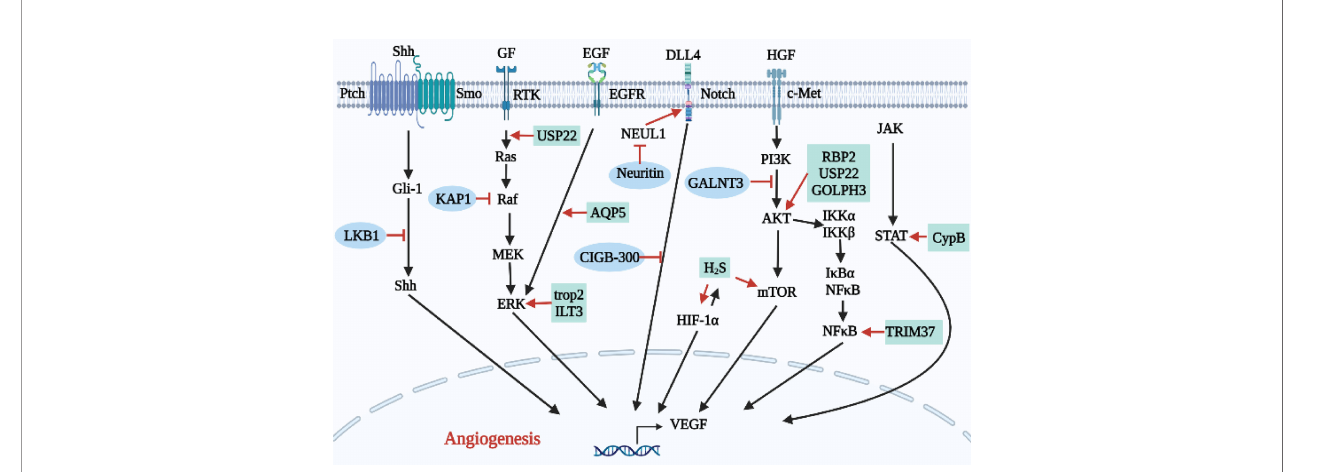
FIGURE 5 | Relationship between proteins and other biomolecules and angiogenesis in lung